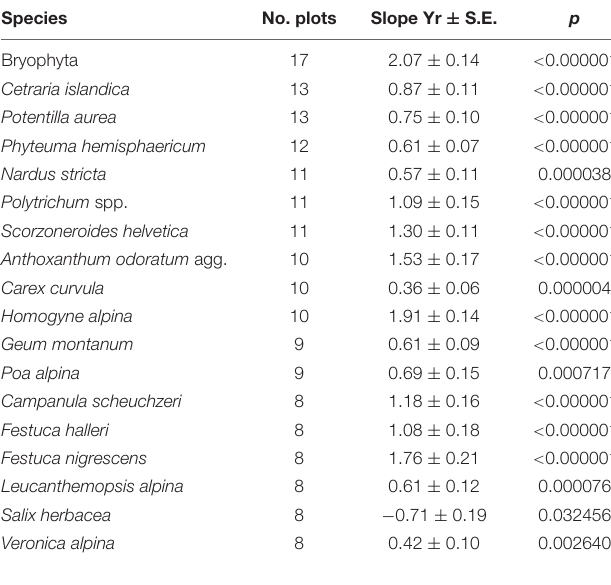
TABLE 3 | Selection of species with significant increase/decrease (only Salix herbacea ) over time (linear trend), number of grazed plots with presences, slope for Yr ± S.E., and Bonferroni-corrected p -values ( p ). Species No. plots Slope Yr ±